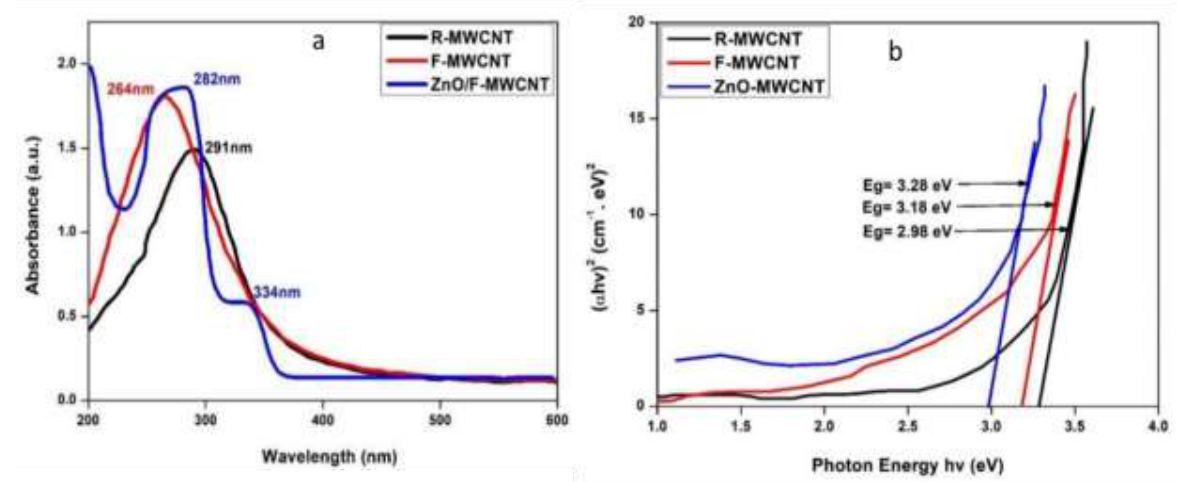
Figure 6: a) Optical absorption spectra of R-MWCNTs, F-MWCNTs, and ZnO\MWCNT hybrid. b) Plots of (αhv)